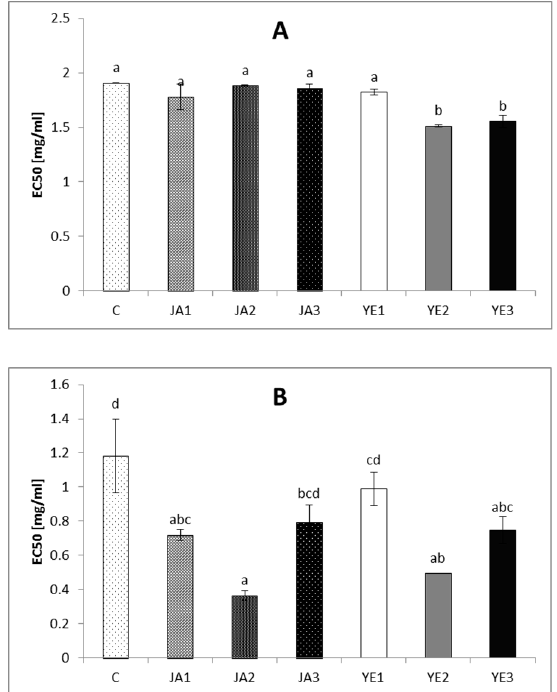
Figure 2. Lipoxygenase ( A ) and cyclooxygenase ( B ) inhibition by phenolics from lovage induced by elicitors; C–control plants, JA1–plants elicited with 1 µ M jasmonic acid, JA2–plants elicited with 10 µ M jasmonic acid JA3–plants elicited with 100 µ M jasmonic acid; YE1–plants elicited with 0.01% yeast